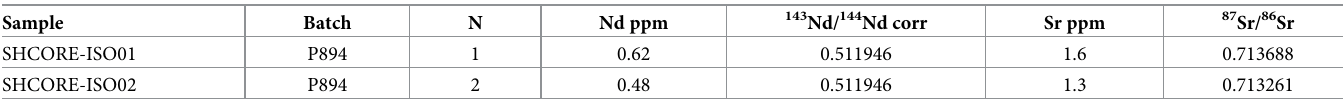
Table 7. Sr and Nd concentrations and 87 Sr/ 86 Sr and 143 Nd/ 144 Nd isotope ratios for the whole-rock samples from the Phillips’ Core at Stonehenge.